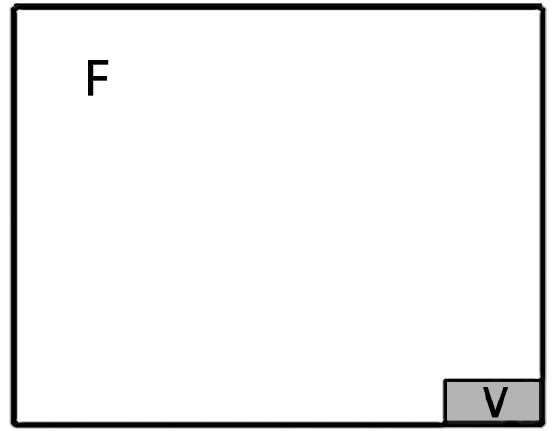
Figure 4 - Lattice for decision-making used in morphological analysis used after making PANN; F: logical state false (it is interpreted as referece not similar); V: logical state true (it is interpreted as reference similar).